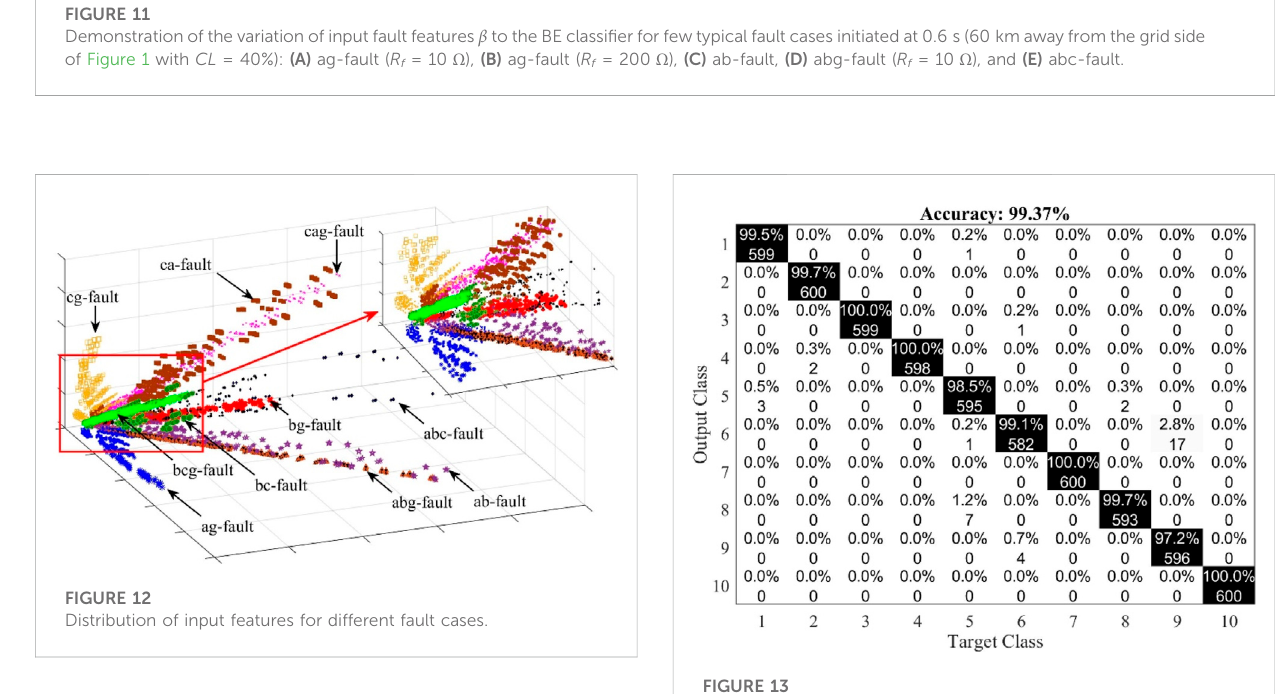
FIGURE 13 Overall confusion matrix of the BE classi fi er.